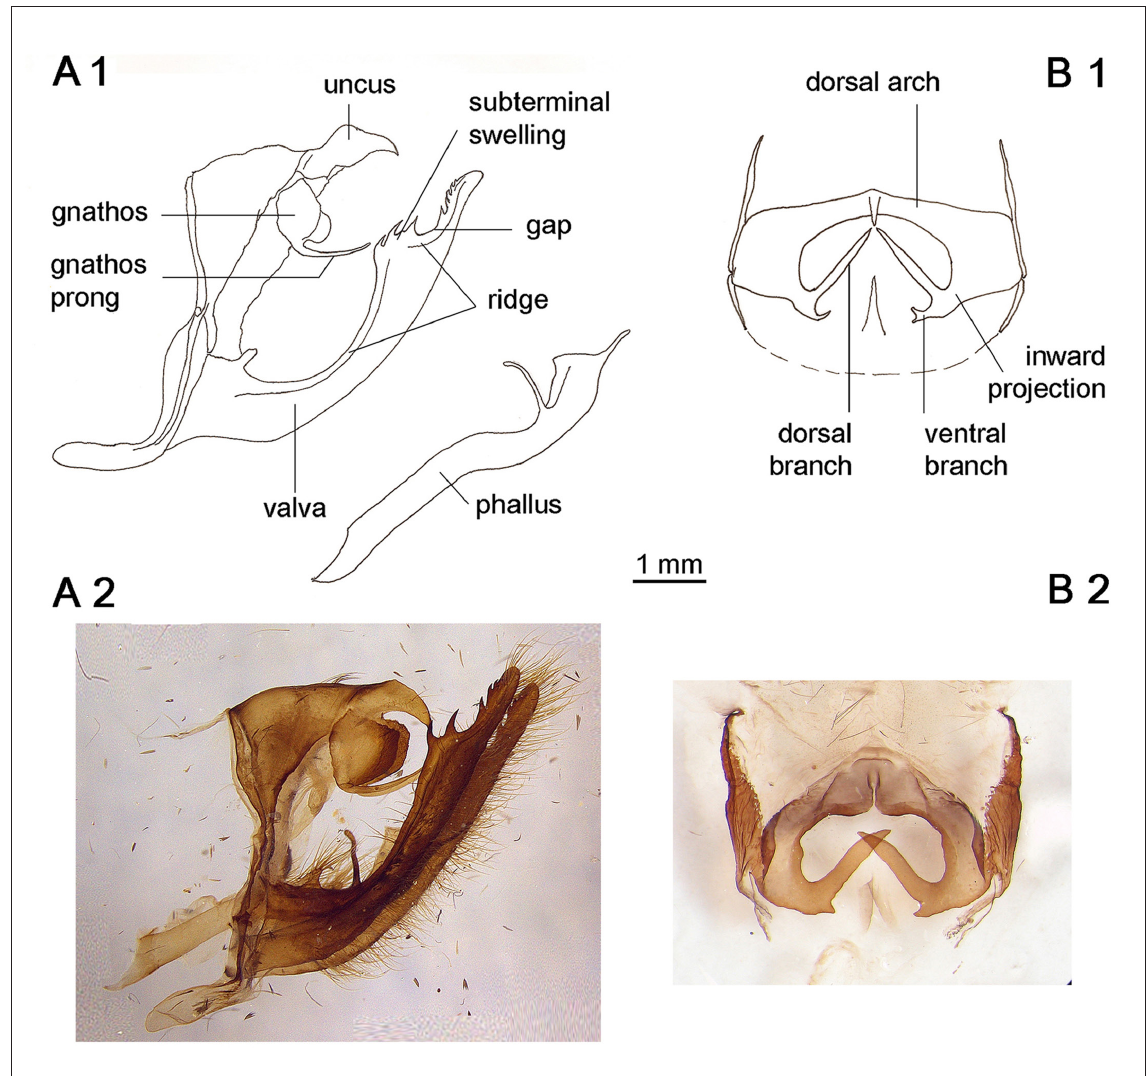
Fig. 3. Characters studied on genitalia. A1 . Male from Bolivia ( Eryphanis zolvizora zolvizora (Hewitson, 1877); MNHN, PBB 2286). A2 . Male from Central Peru (La Suiza, Pasco; UFPC; PT of